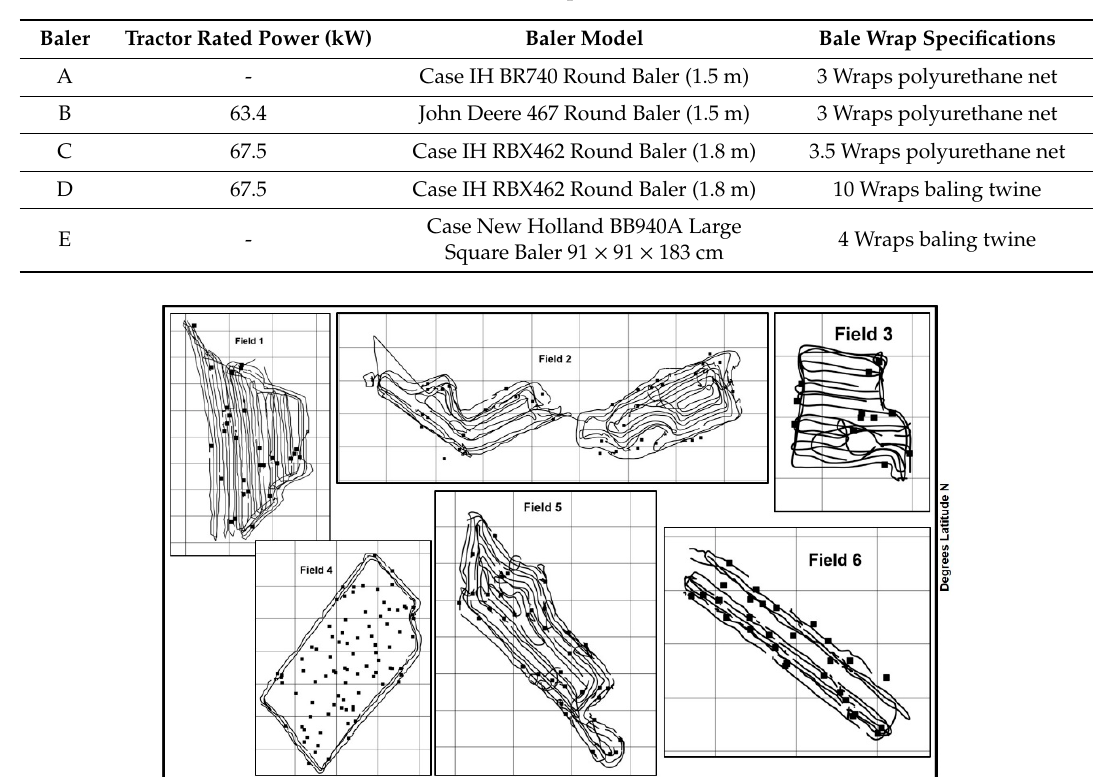
Figure 1. Traffic patterns of Fields 1-6 baled with conventional baling equipment. (Lines are the traffic pattern and square symbol represents where the bale was dropped. Figures are not to scale. Traffic pattern missing for Field 4 due to DGPS malfunction.).